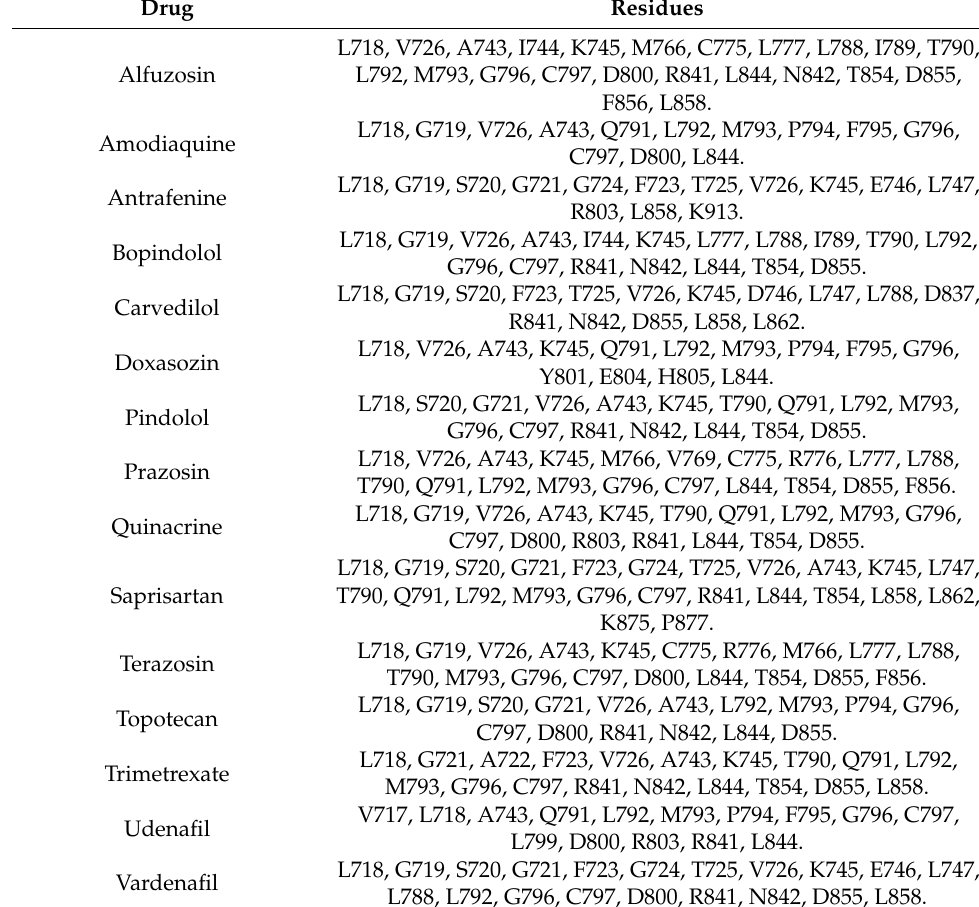
Table 2. Interactions between inhibitors selected in DrugBank and EGFR during